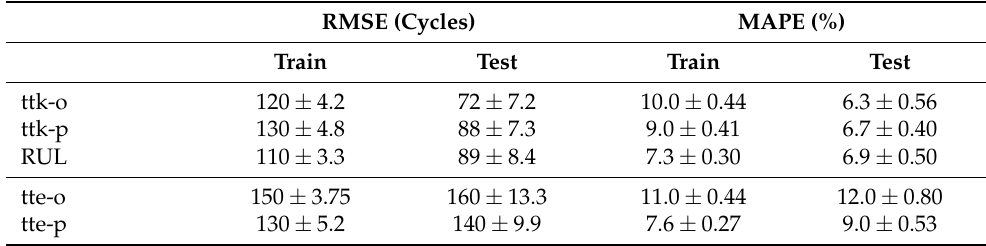
Table 2. Performance of proposed model on Baumhöfer dataset to predict Capacity’s: ttk-o, ttk-p and RUL; and IR’s: tte-o and tte-p. Average performance from within the first 100 cycles per test cell (10 cells). RMSE (Cycles) MAPE (%) Train Test Train